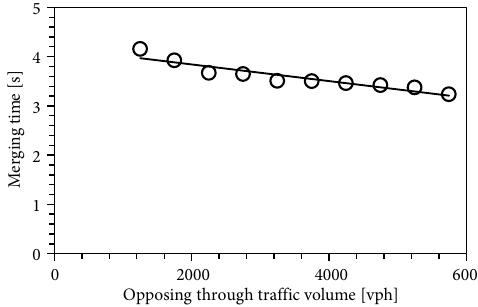
Fig. 11. Effect of opposing traffic on MT for the